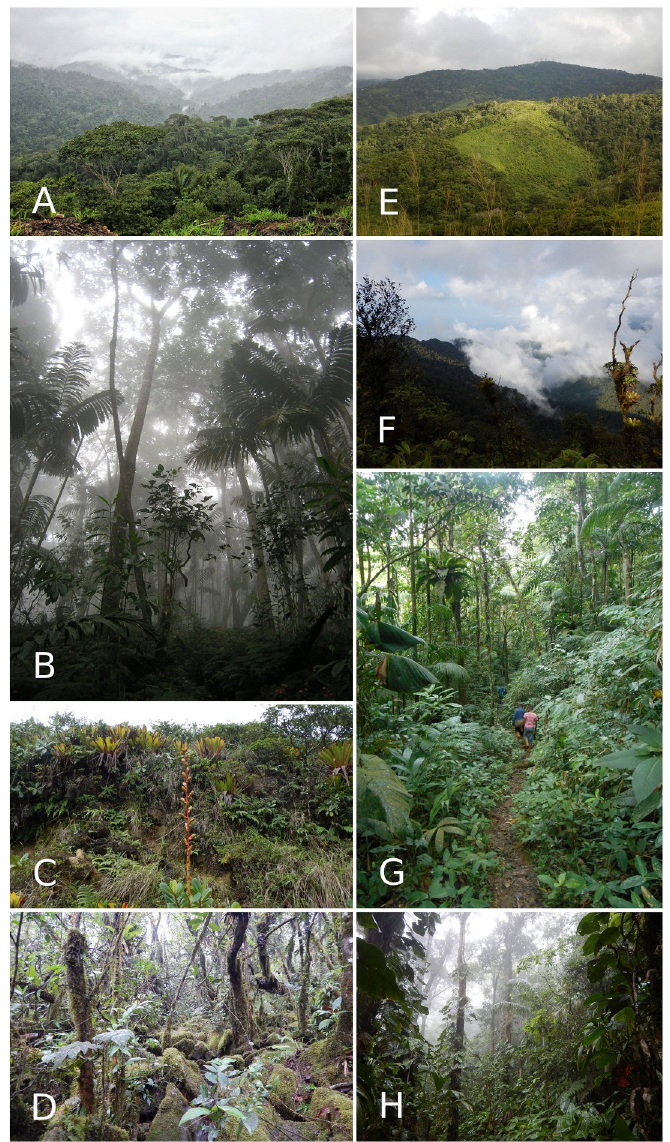
Fig 2. Vegetation in Venezuela’s northernmost montane coastal systems. A. General view of the evergreen montane forest in Sierra de Aroa on the western side of Central Coastal Range Yaracuy state. B. Cloud forest in the Central Coastal Range. Monumento Natural Pico Codazzi, Aragua state. C. Summit of Cerro El Copey on Isla de Margarita. Glomeropitcairnia erectiflora mostly grows on the ground in Copey’s Summit. D. Elfin forest around 700 m in elevation in Cerro El Copey. E. Evergreen forest in Cerro La Cerbatana. F. View of the top of Cerro Campeare G. Cerro Las Melenas and Cerro El Padre seen from Cerro Humo summit. H. Cloud forest surrounding the town of Las Melenas (750 m), near Cerro Humo. Photos by Helga Terzenbach (A), Aurelien Miralles (B), Gilson Rivas (C-F, H), Luis Sibira